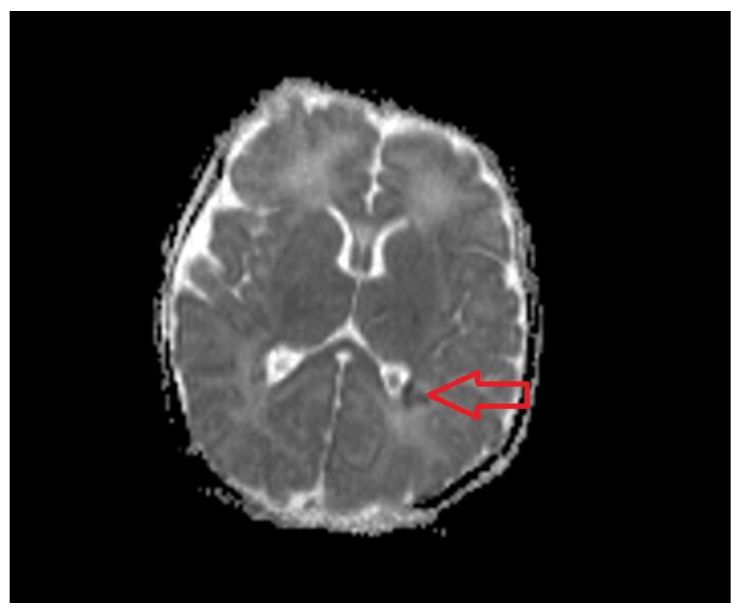
Figure 6. MRI on Day 5. ADC map: white matter lesion, left (shown by the arrow). The patient was discharged from the hospital at 10 days of life.